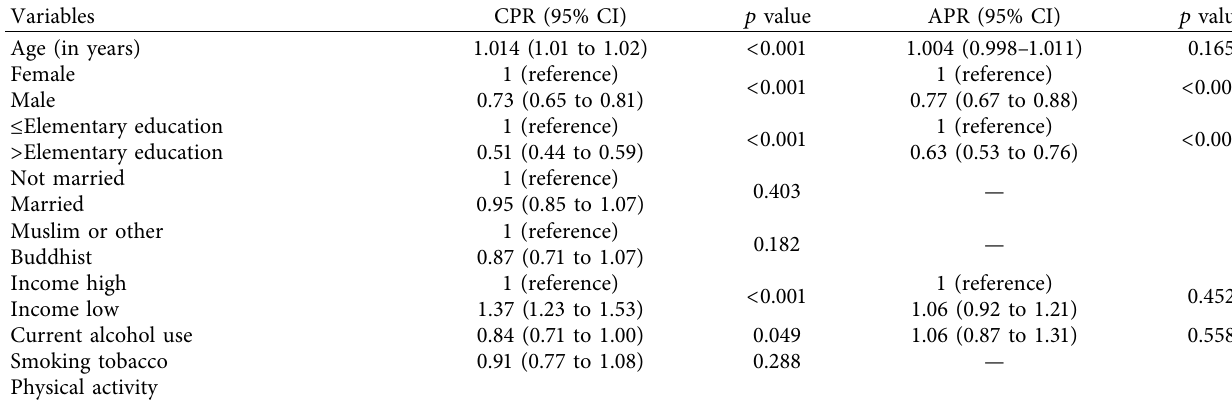
Table 3: Associations with cross-sectional pain, HART